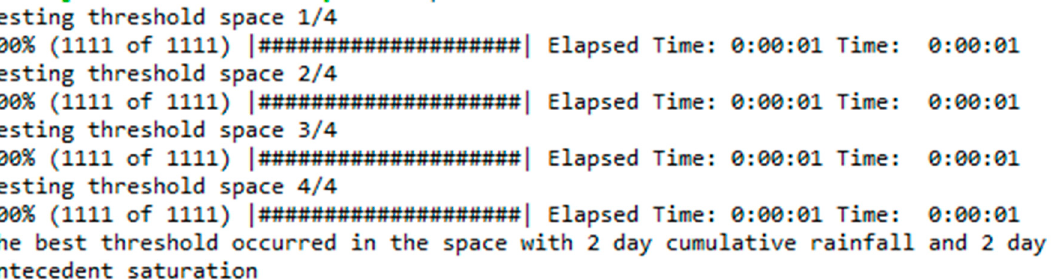
Figure 6. Example of the elapsed time of each daily threshold calculation from the repository. Once all four are calculated, the optimal threshold based on the desired ROC metric is shown, as seen above. For this analysis, the optimal threshold was identified with a 2-day cumulative rainfall and a 2-day antecedent saturation.